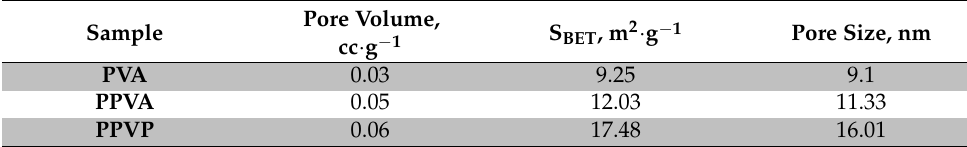
Table 2. The pore volume, surface area (S BET ) and pore size of PVA, PPVA and PPVP.